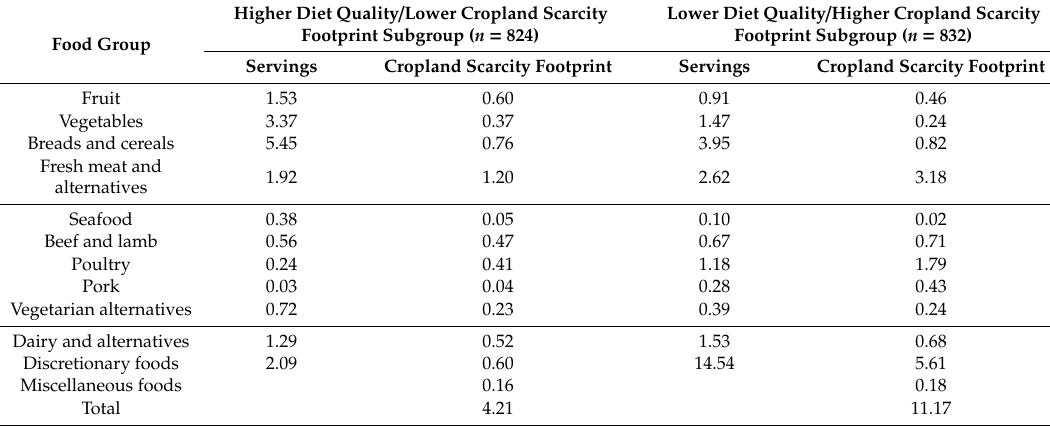
Table 2. Food intake (servings person − 1 ) and cropland scarcity footprint (m 2 yr-e person − 1 ) of Australian adult (19–50 years) daily